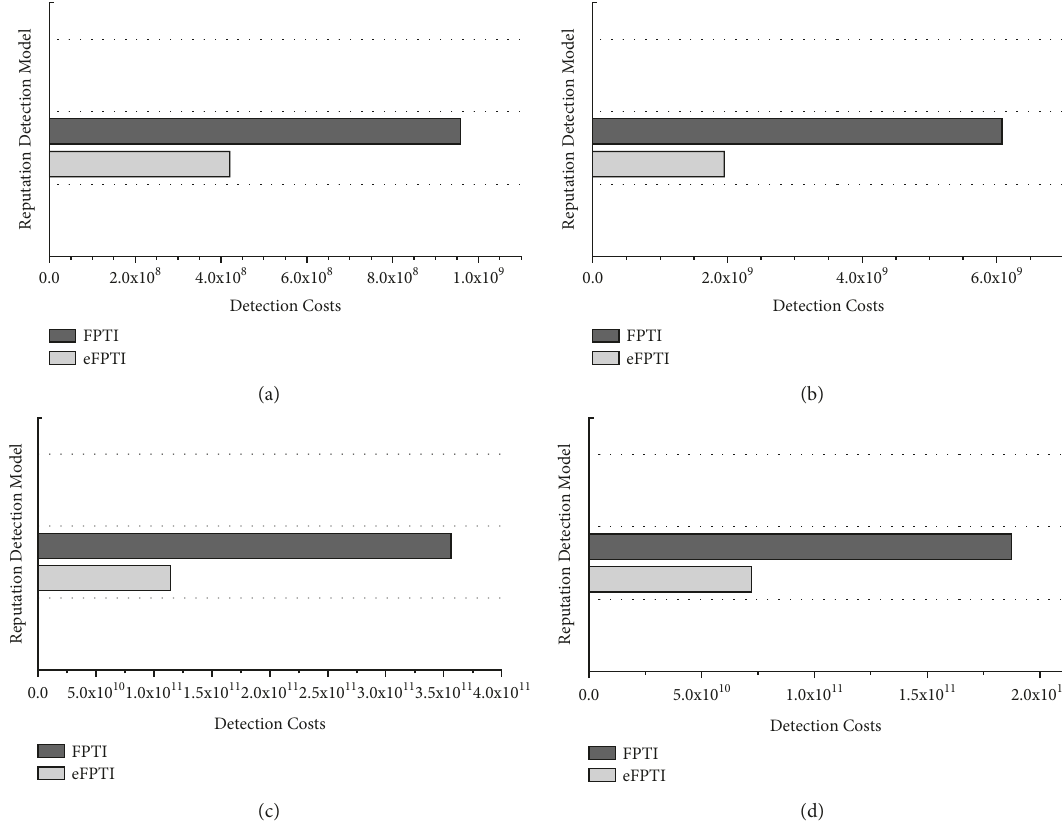
Figure 9: Comparison of the proposed reputation detection models (FPTI vs. eFPTI) on the detection costs. (a) Detection costs in FB network. (b) Detection costs in OLY network. (c) Detection costs in POL network. (d) Detection costs in RUG